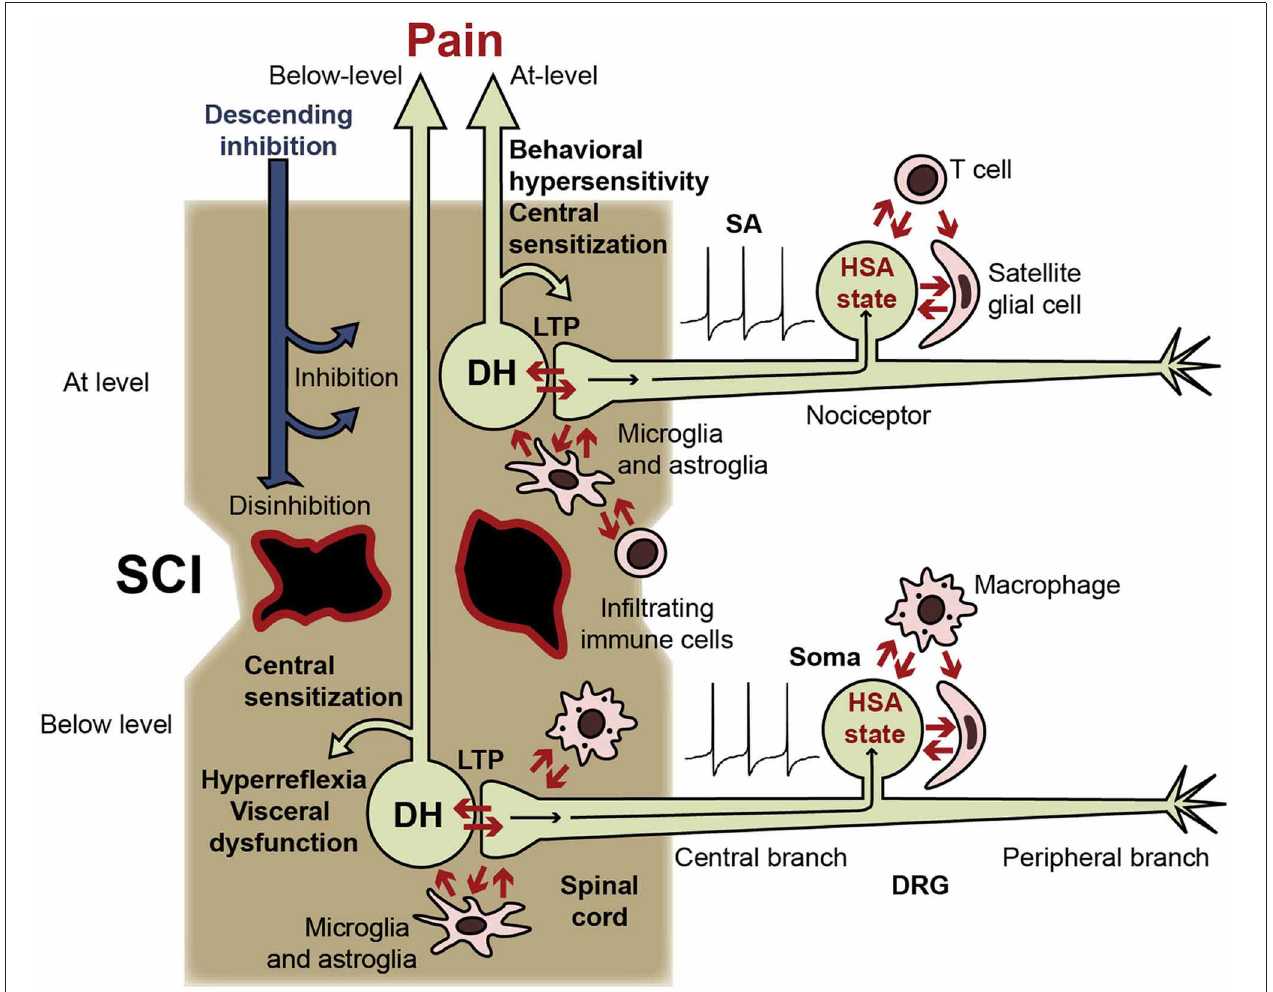
FIGURE 1 | Central and somal signals received by nociceptors during SCI, and consequences of switching nociceptors into a persistent hyperfunctional state. Nociceptors receive injury-related signals within the spinal cord (from intensely activated postsynaptic dorsal horn neurons [DH], activated glia, and infiltrating immune cells) and within the DRG (from other DRG neurons, satellite glial cells, and the blood). Nociceptors have potent excitatory effects on pain pathways (indicated by DH neurons) and on circuits subserving somatic and visceral functions (not shown). LTP at DH synapses can be produced by somal and peripheral SA and afterdischarge, facilitated by the nociceptor hyperfunctional state (including the somal hyperexcitable/SA [HSA] state). Nociceptor activity produces central sensitization, promotes spontaneous and evoked pain, and enhances somatic and visceral reflexes. Nociceptor activity also leads to positive feedback interactions with postsynaptic neurons, other DRG somata, inflammatory cells (microglia, infiltrating macrophages, and T cells), astrocytes, and satellite glial cells.